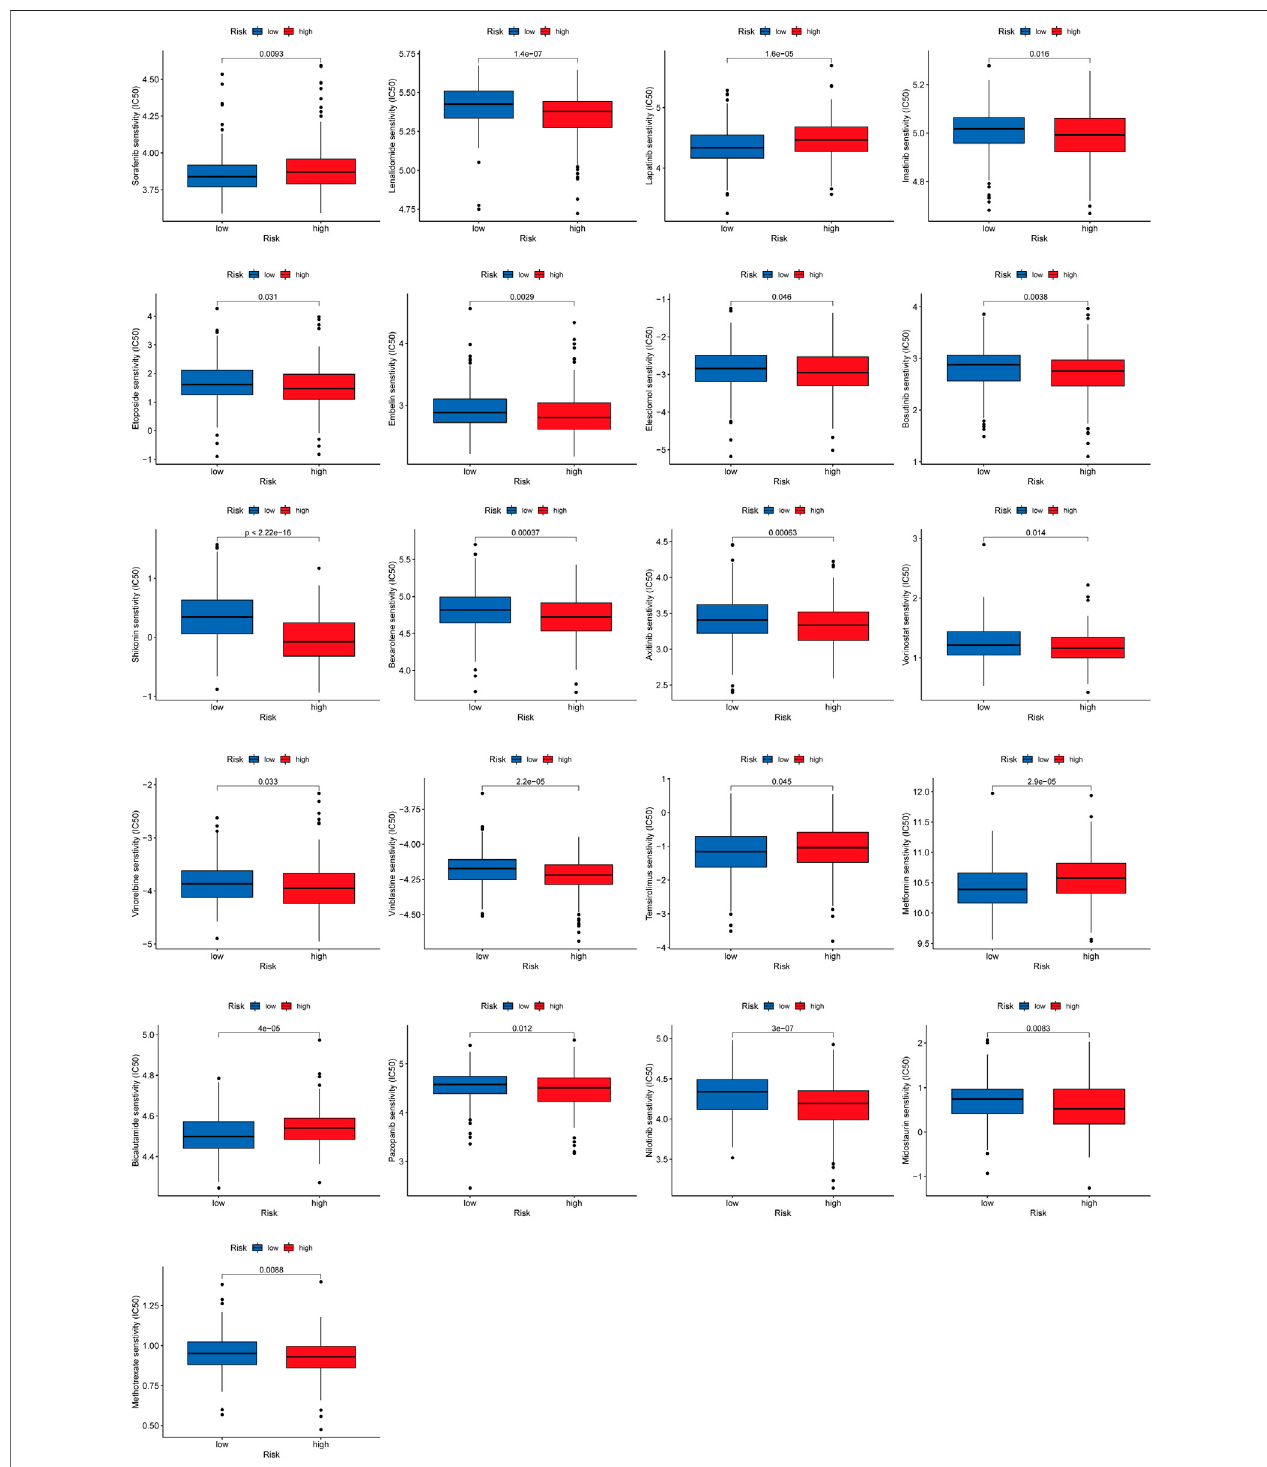
FIGURE 12 | Anti-tumor drug sensitivity in high RMlnc-score and low RMlnc-score populations.